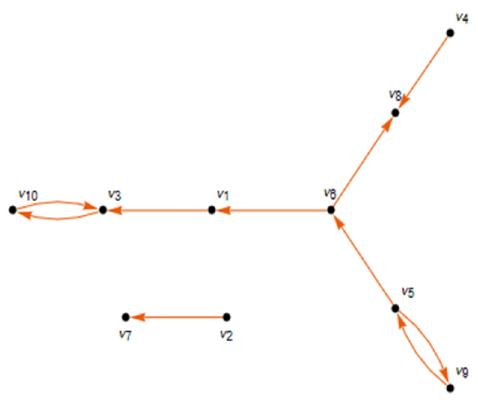
Figure 1. Directed network. Note: The vertex set is V = { v 1 , v 2 , . . . , v 10 } .